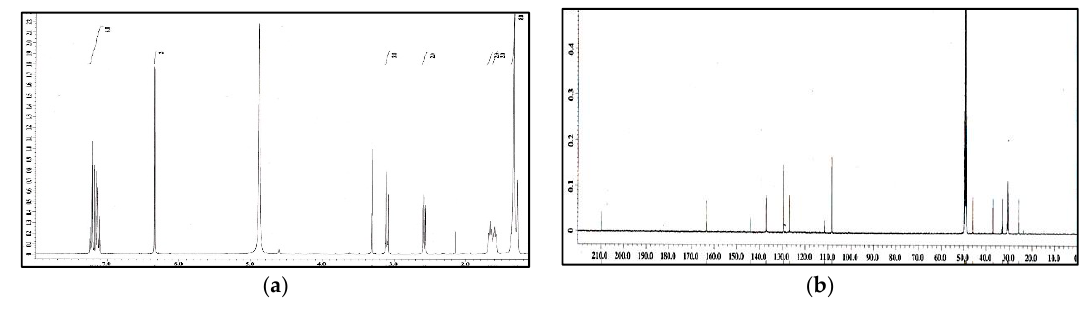
Figure 2. 1 H-NMR ( a ) and 13 C-NMR ( b ) spectra of compound 1 .